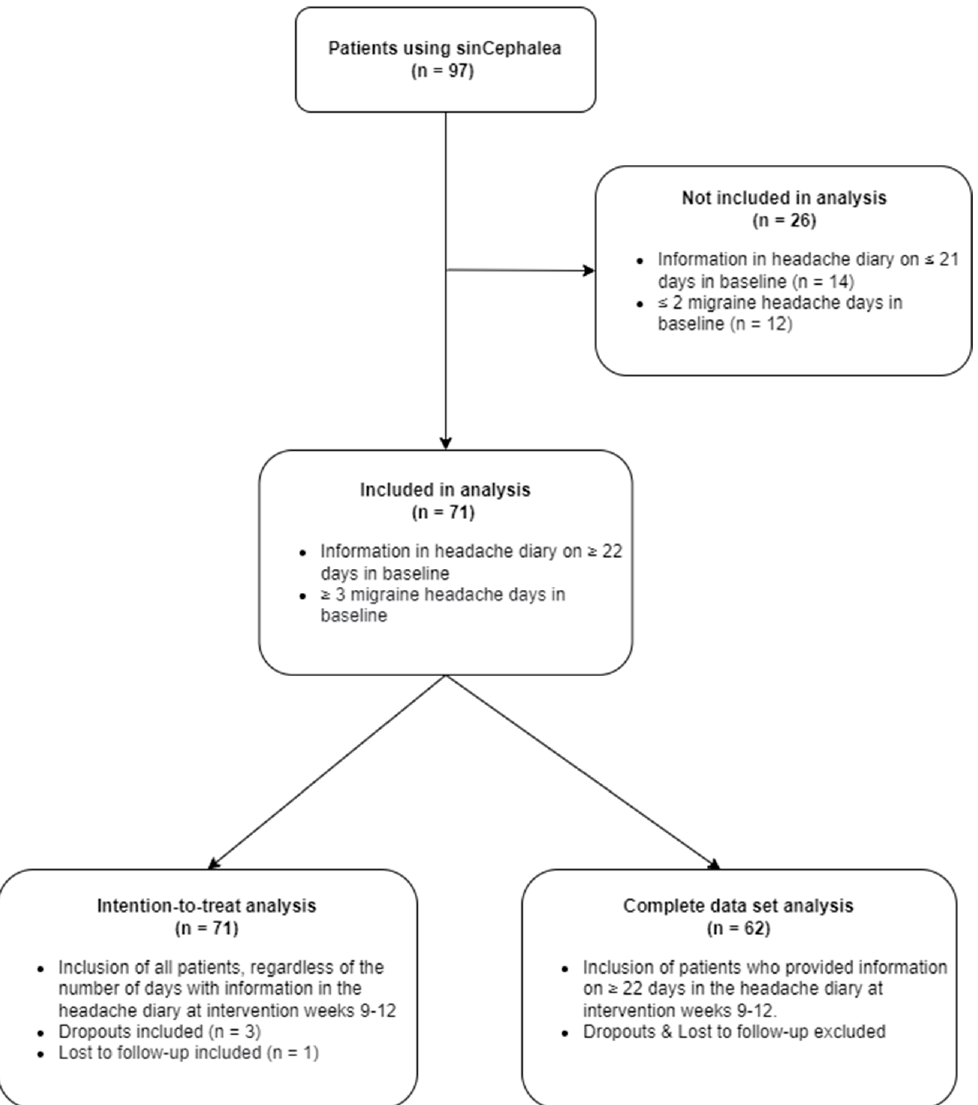
Figure 3. Flow chart of patients included in the second study. 97 patients activated the access code to the DTx sinCephalea. 71 patients were included in the analysis as they fulfilled the criteria of completed headache diary on at least 22 days and reported migraine headache on at least three days in the baseline phase. 62 patients also provided information on at least 22 days of the last four weeks of the intervention phase and were included in the completed data set analysis. Missing data of the last four weeks of the intervention phase from the remaining nine patients was analyzed using imputation with baseline-observation-carried-forward (intention-to-treat